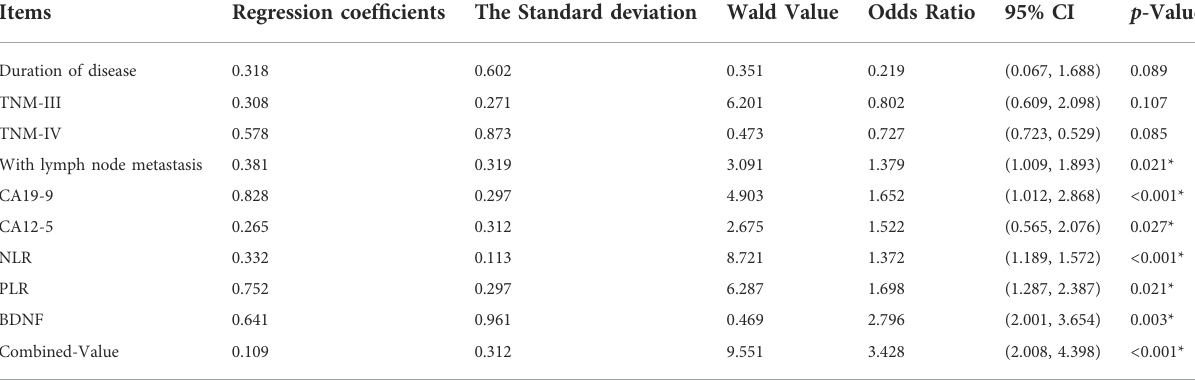
TABLE 3 | Multivariate Logistic Regression Analysis of Risk Factors Related to Ovarian Cancer.